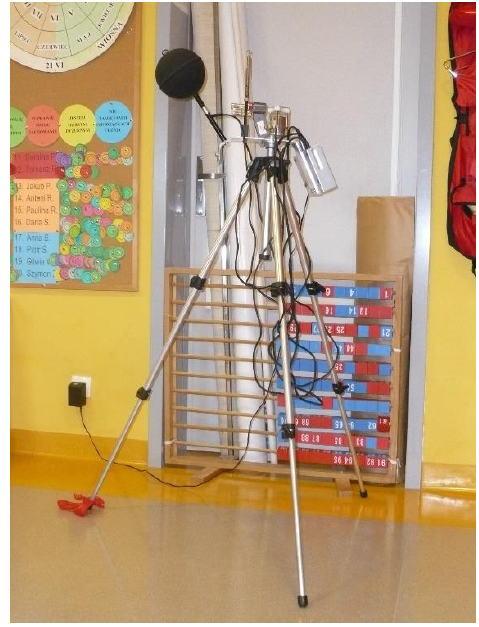
Figure 2. BABUC A digital microclimate meter (author’s archive).